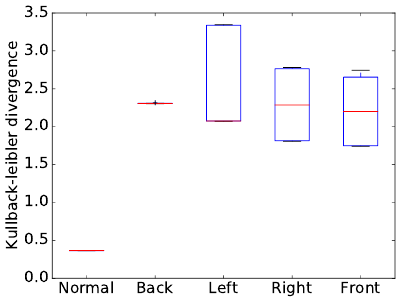
Figure 4. Kullback–Leibler divergence compared to uniform distribution in various illumination